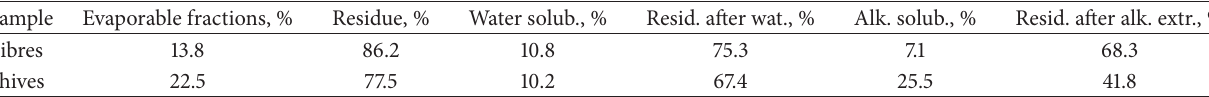
Figure 6: FTIR spectra corresponding to electrospun fibres and shives/PVA composites. Table 2: Modes of hemp samples after SE and after treatment [21].